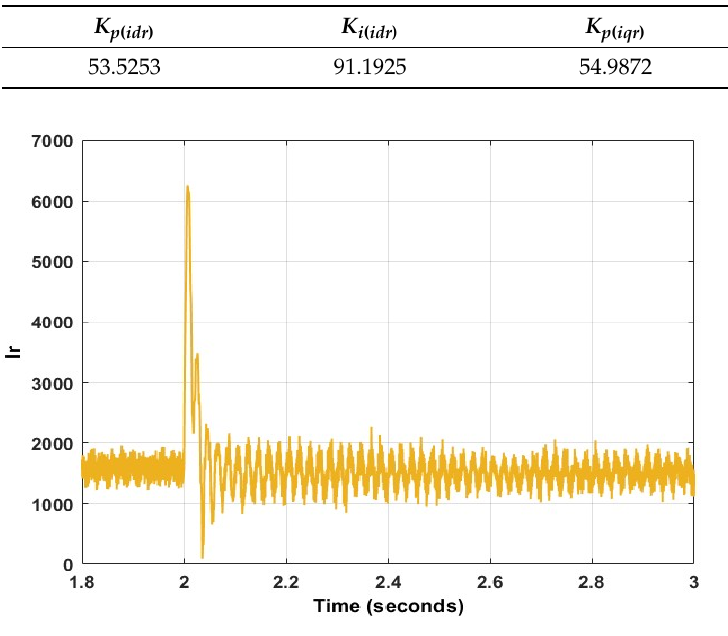
Figure 21. Rotor current transient using PI at 70% dip.